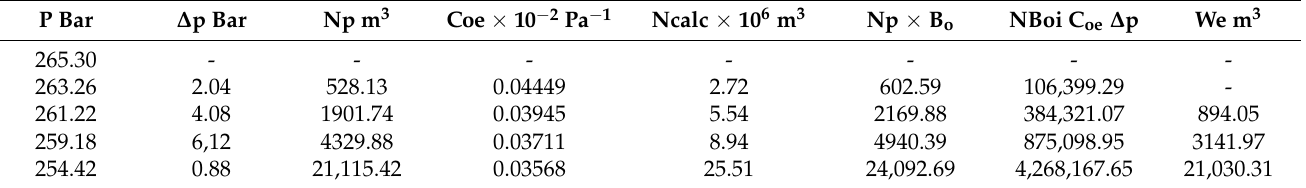
Table 3. Calculation of material balance for the Shueib formation using Shueib PVT Data, where N